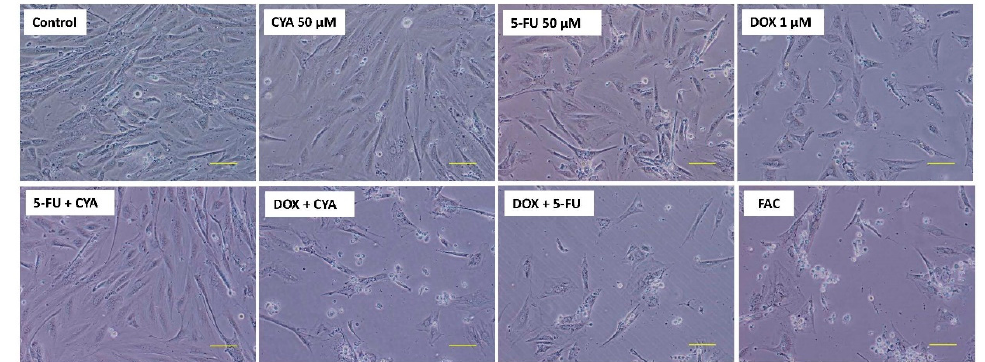
Figure 8. Phase contrast microscopy of differentiated H9c2 cells after 48 h incubation with FAC, other mixtures of DOX (1 μ M), 5-FU (50 μ M) and CYA (50 μ M) and the drugs alone. Images are representative of two independent experiments (scale bar 100 μ m).